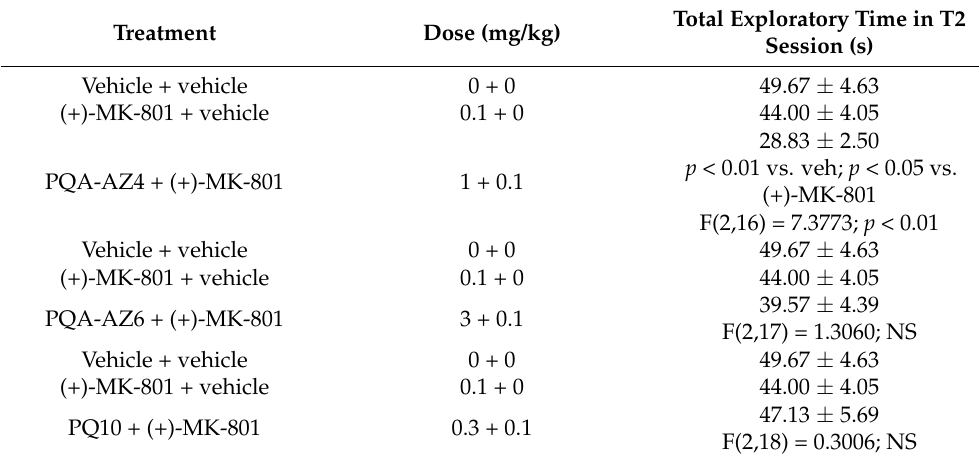
Total Exploratory Time in T2 Session (s)